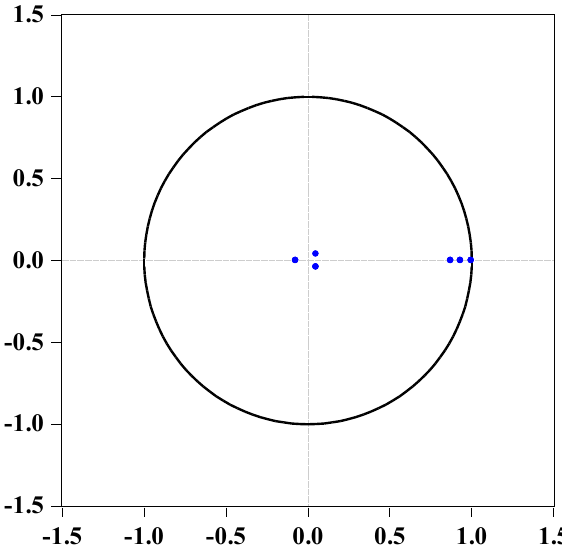
Figure 1. The results of the stability test.